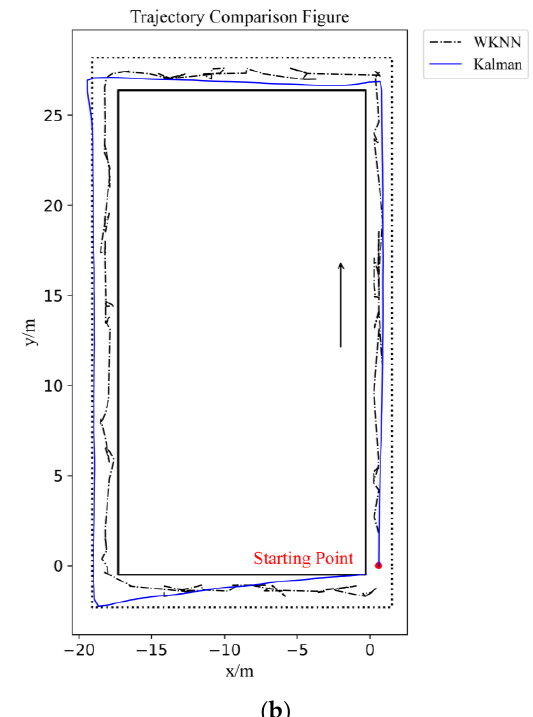
Table 4. Comparisons of errors of three algorithms.